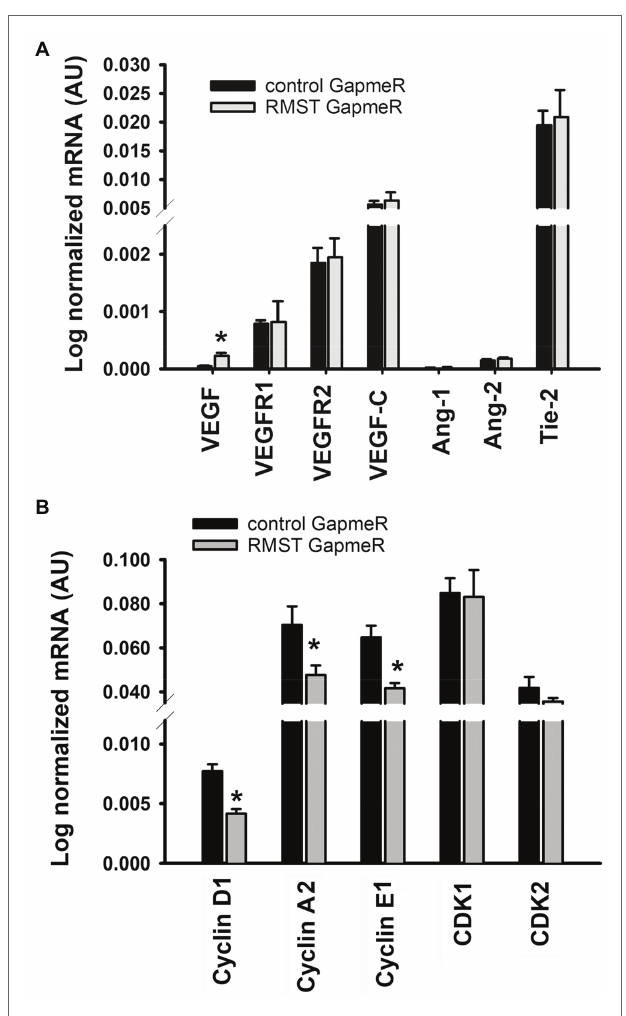
FIGURE 6 | RMST regulation of angiogenesis and the cell cycle. mRNA expressions of VEGF, VEGFR1, VEGFR2, VEGF-C, Ang-1, Ang-2, Tie-2 (panel A ), cyclins D1, A2, and E1, and CDK1 and CDK (panel B ) in control or RMST GapmeR-transfected HUVECs. Total RNA was extracted 48 h post-transfection. Values are means ± SEM. * p < 0.05, compared to control GapmeR. N =